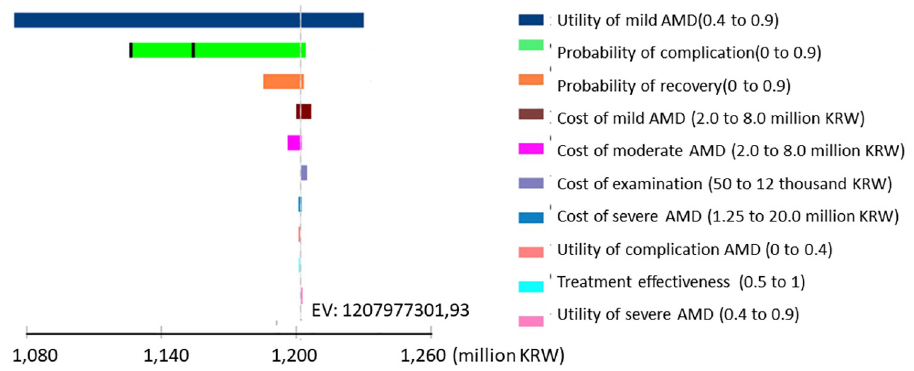
Fig 2. Tornado diagram of the range of net monetary benefits at willingness-to-pay threshold 30,000,000 KRW per QALY for all major model parameters.